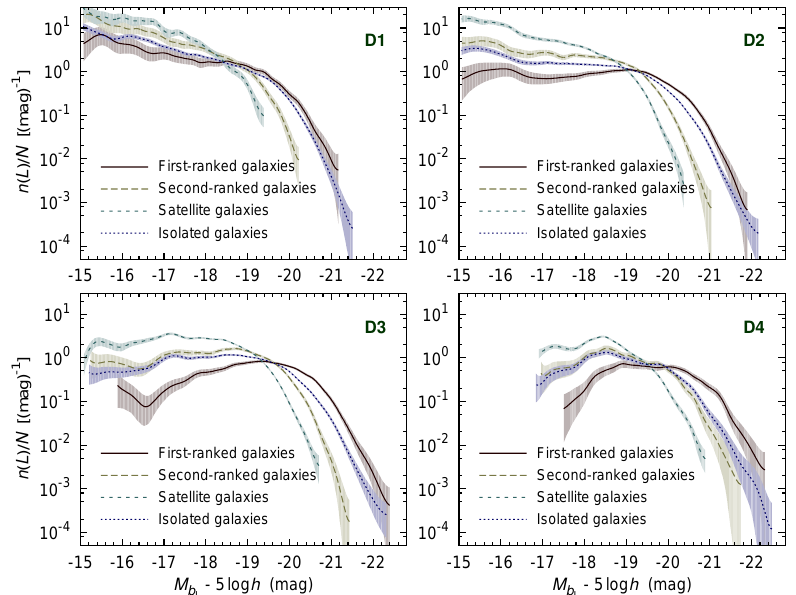
Fig. 5. Differential LFs in different environments and for different galaxy populations. Solid lines show the first-ranked galaxies; dashed lines – the second-ranked galaxies; short- dashed lines – satellite galaxies; dotted lines – isolated galaxies. The shaded areas show the 95% confidence